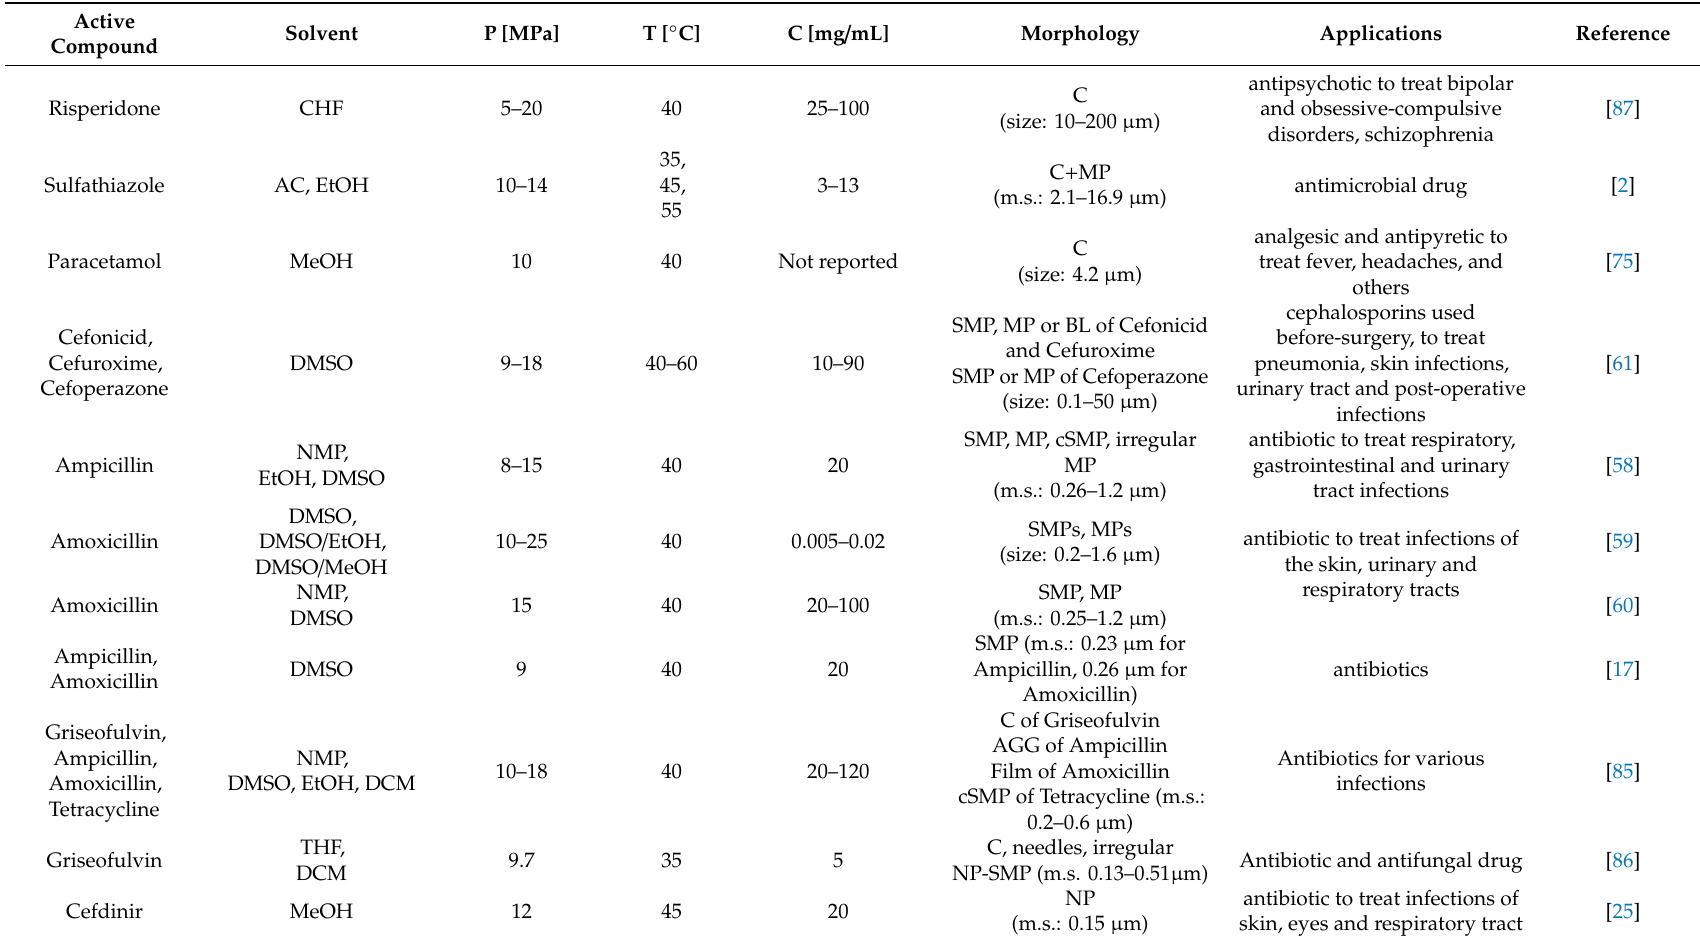
Table 1. An overview of SAS micronization of active compounds. C: Crystals; NP: Nanoparticles; SMP: Sub-microparticles; MP: Microparticles; BL: Balloons; c: Coalescent; AGG: Aggregates; m.s.: Mean size; NSAID: Nonsteroidal anti-inflammatory drug; DLBS2347: Manilkara kauki L. Dubard’s leaf extract;